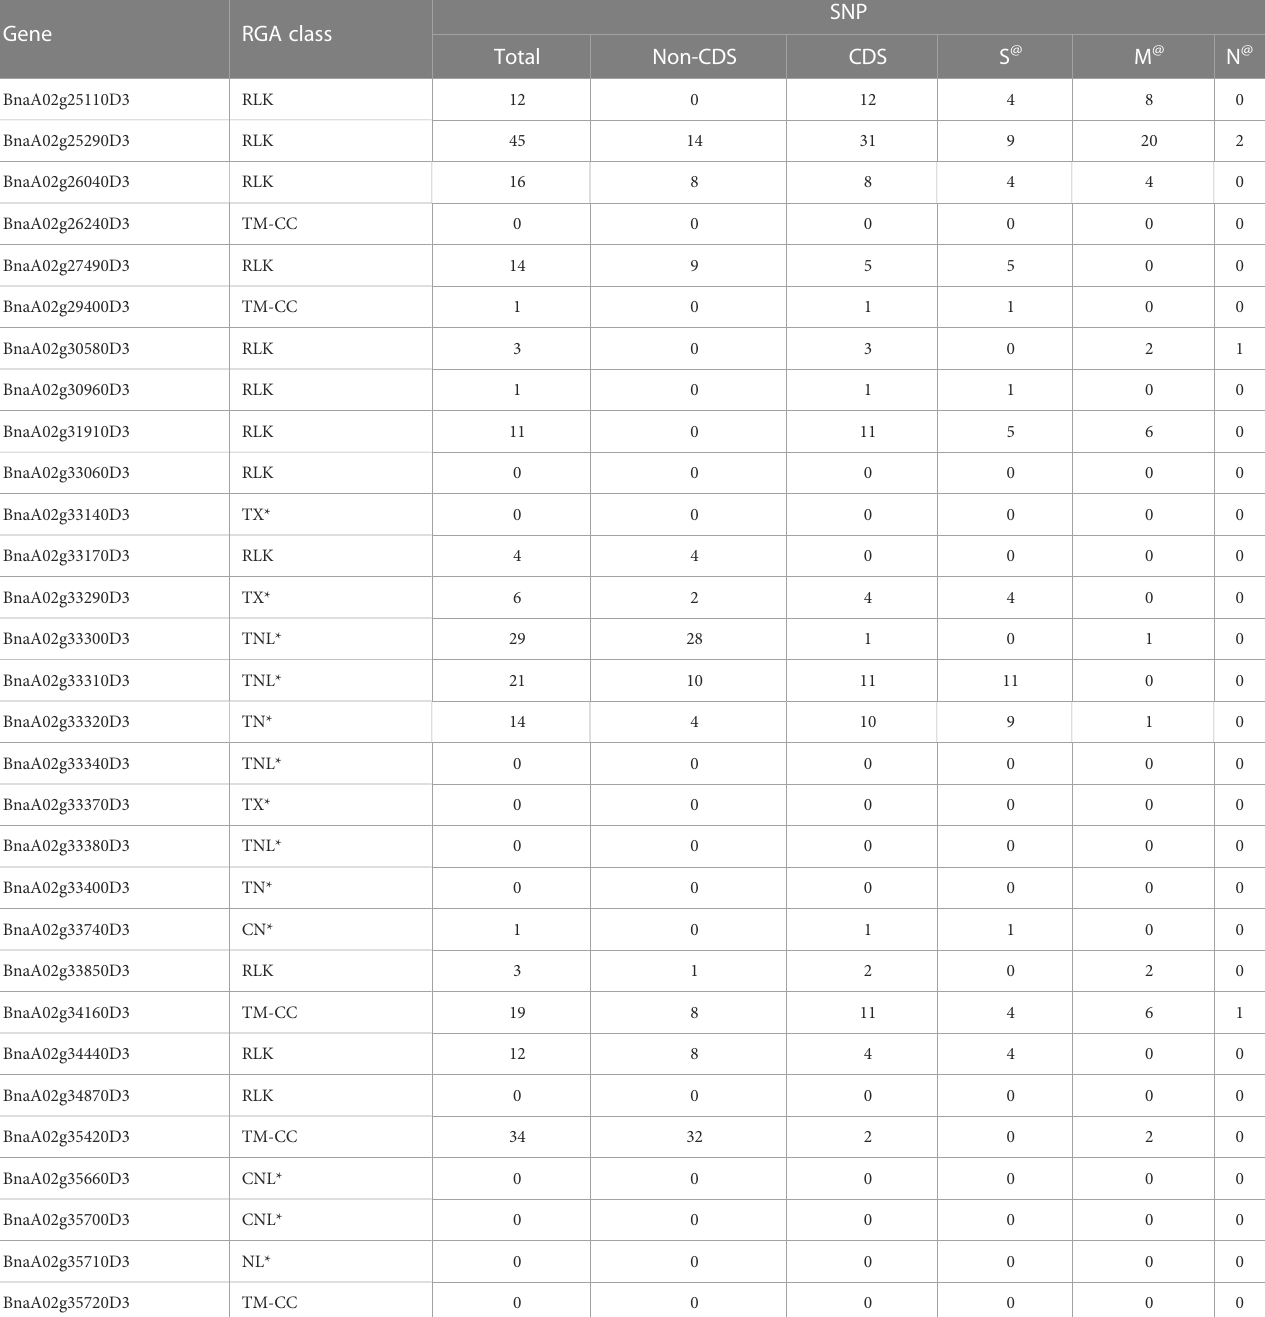
TABLE 2 List of resistance gene analogs (RGA) and their single nucleotide polymorphism (SNP) information within LepR1 _mlm1 on chromosome A02 of Brassica napus cv. Darmor bzh v9 identi fi ed using mixed linear (MLM) genome wide association study (GWAS).